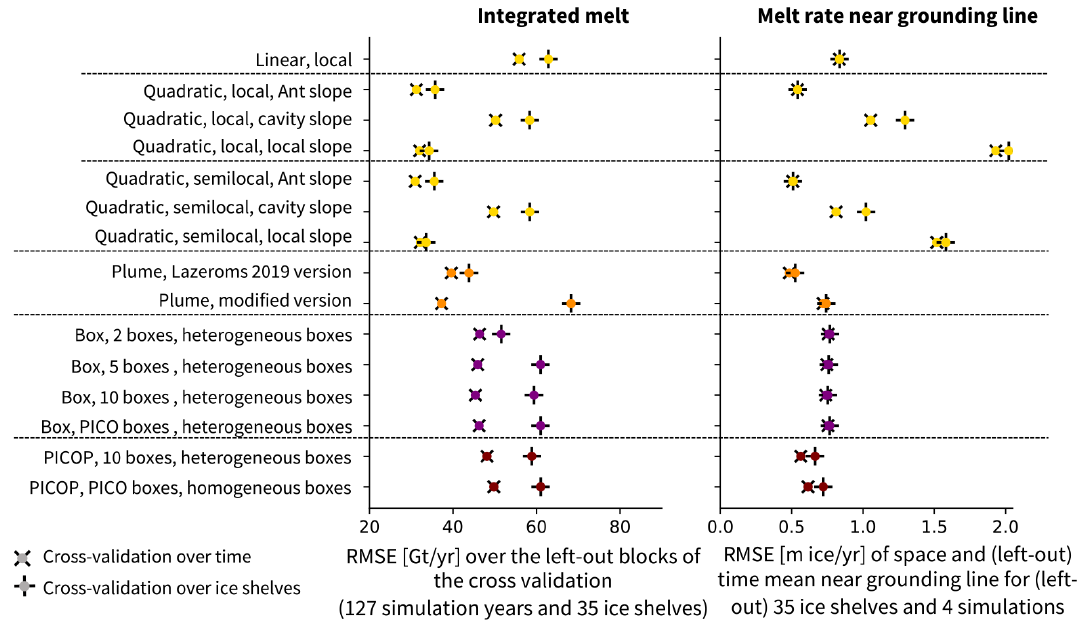
Figure 7. Summary of the RMSE of the integrated melt (RMSE int ) for the cross-validation over time ( × ) and for the cross-validation over ice shelves ( + ) for a selection of parameterisations, using the 50km domain (in gigatonnes per year) (left, same as Fig. 4 left), and summary of the RMSE of the melt rate averaged over time and space near the grounding line (average in the first box of the five-box setup, RMSE GL ) (in metres of ice per year) (right). The colours represent the different parameterisation approaches: simple (yellow), plume (orange), box (purple), and PICOP (brown). The RMSE is computed following Eq. (33, left panel) and Eq. (35, right panel) on the synthetically independent evaluation dataset. “Ant slope” stands for “Antarctic